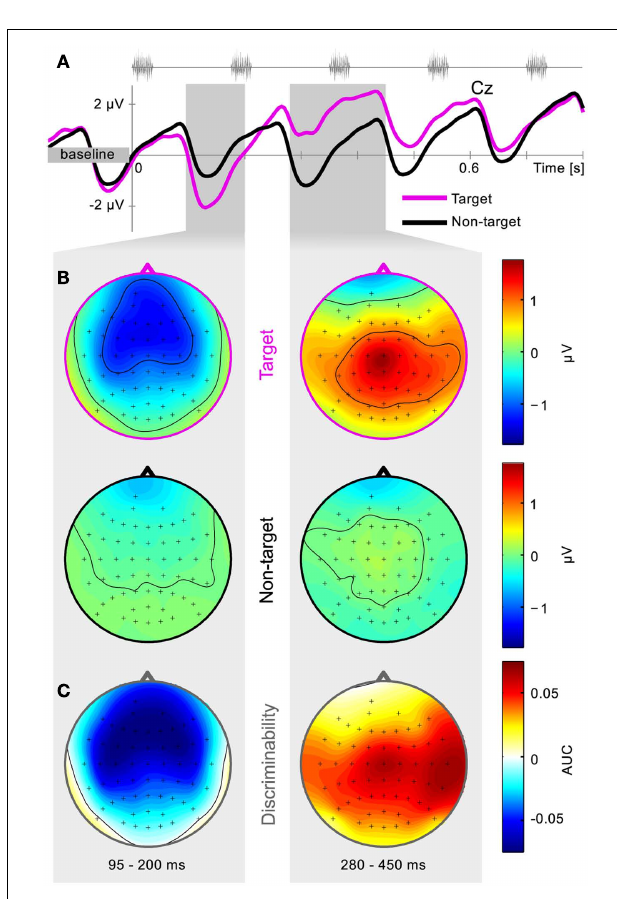
FIGURE 6 | Grand-average physiology. Calibration data of the first session is collapsed over subjects and trials. Average time series for channel Cz are plotted together with the positions of five consecutive stimuli (A) . Scalp potential distributions for target and non-target trials are shown in (B) and distributions of class-discriminative information in (C) .Two intervals were hand-picked based on the signed AUC values, and are represented by the shaded gray areas. Early negative components over frontal and temporal regions are followed by a positive component over centro-parietal areas.